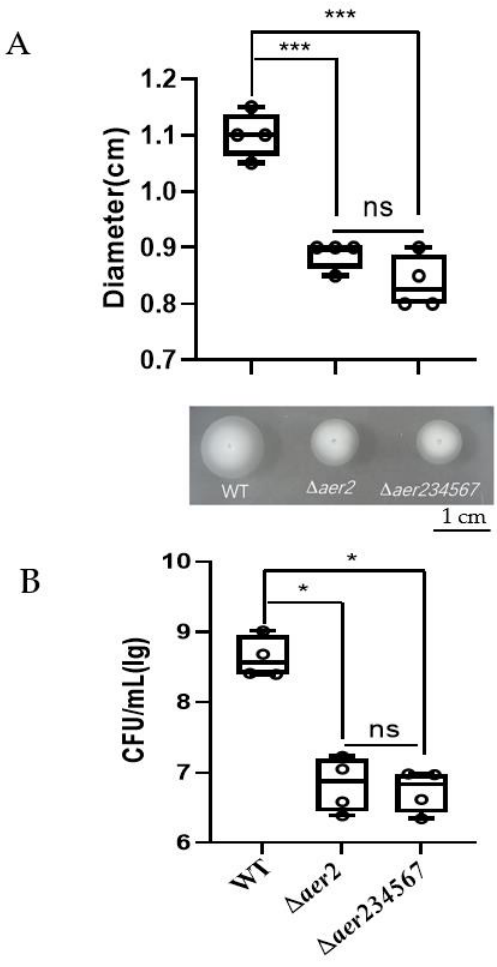
Figure 3. Swarming motility assay. The migration ability of WT, ∆ aer2 , and ∆ aer234567 mutants using a soft-agar plate after 24 h incubation at 30 °C ( A ), or by calculating CFU on the medium-air contact surface of the Pasteur pipette in the air trap assay ( B ). *, p < 0.05; ***, p < 0.001; ns, no significance (Student t -test).